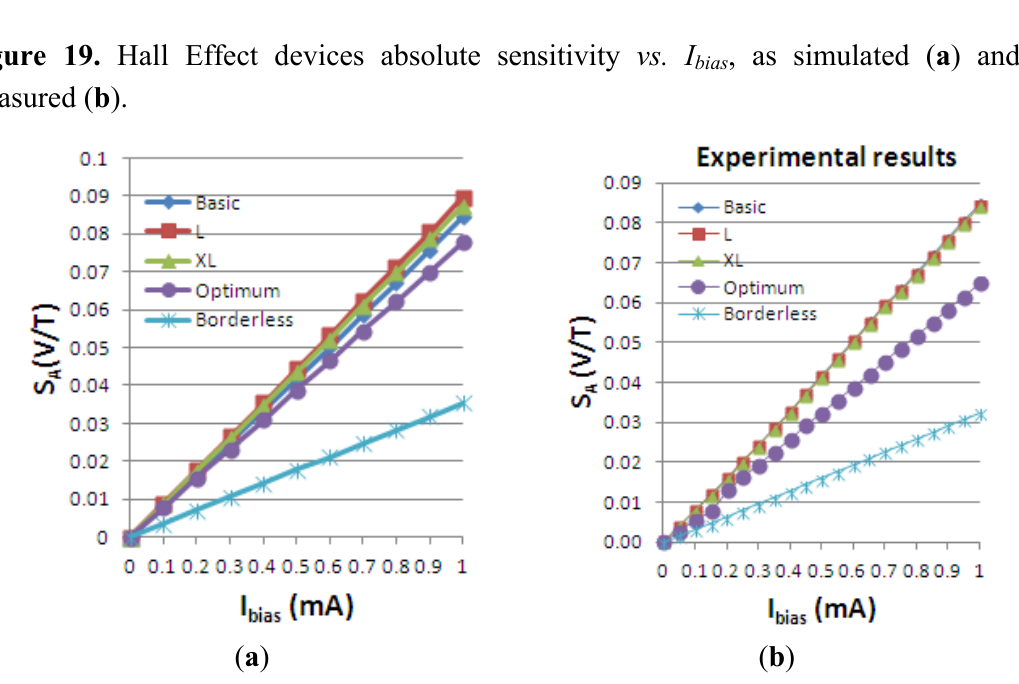
, as simulated ( a ) and as bias